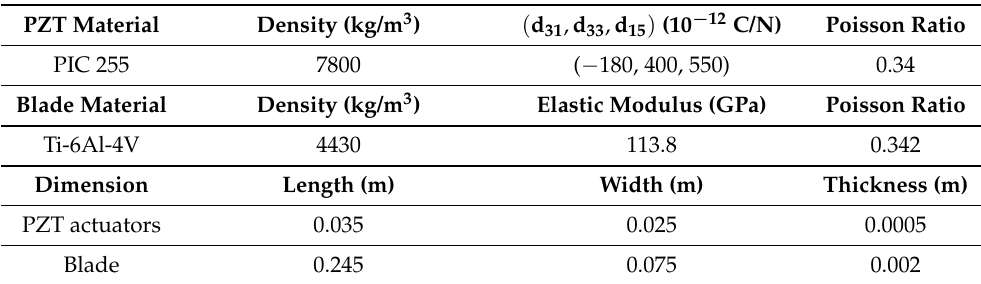
Table 1. Material and dimensions of the blade and PZT